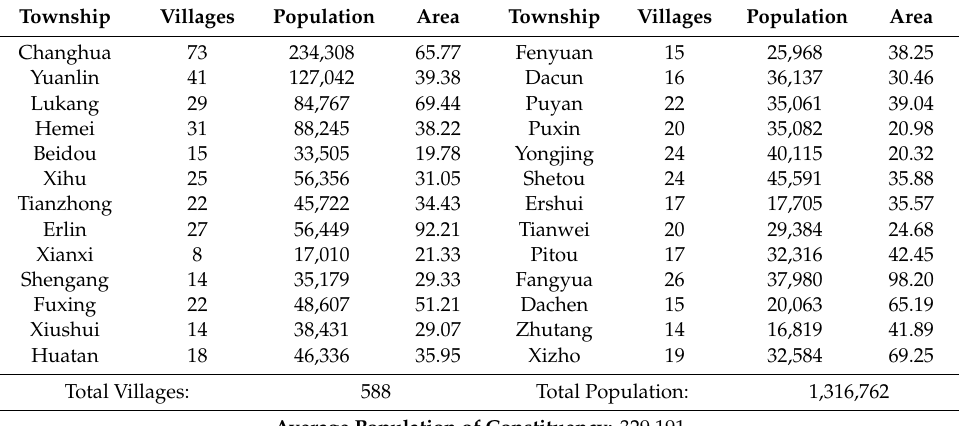
Figure 6. Administrative map of Changhua County: ( a ) Townships, and ( b ) villages, and the higher the population of the villages, the darker the shade. Table 1. Administrative zones information (area unit: km 2 ) of Changhua County.